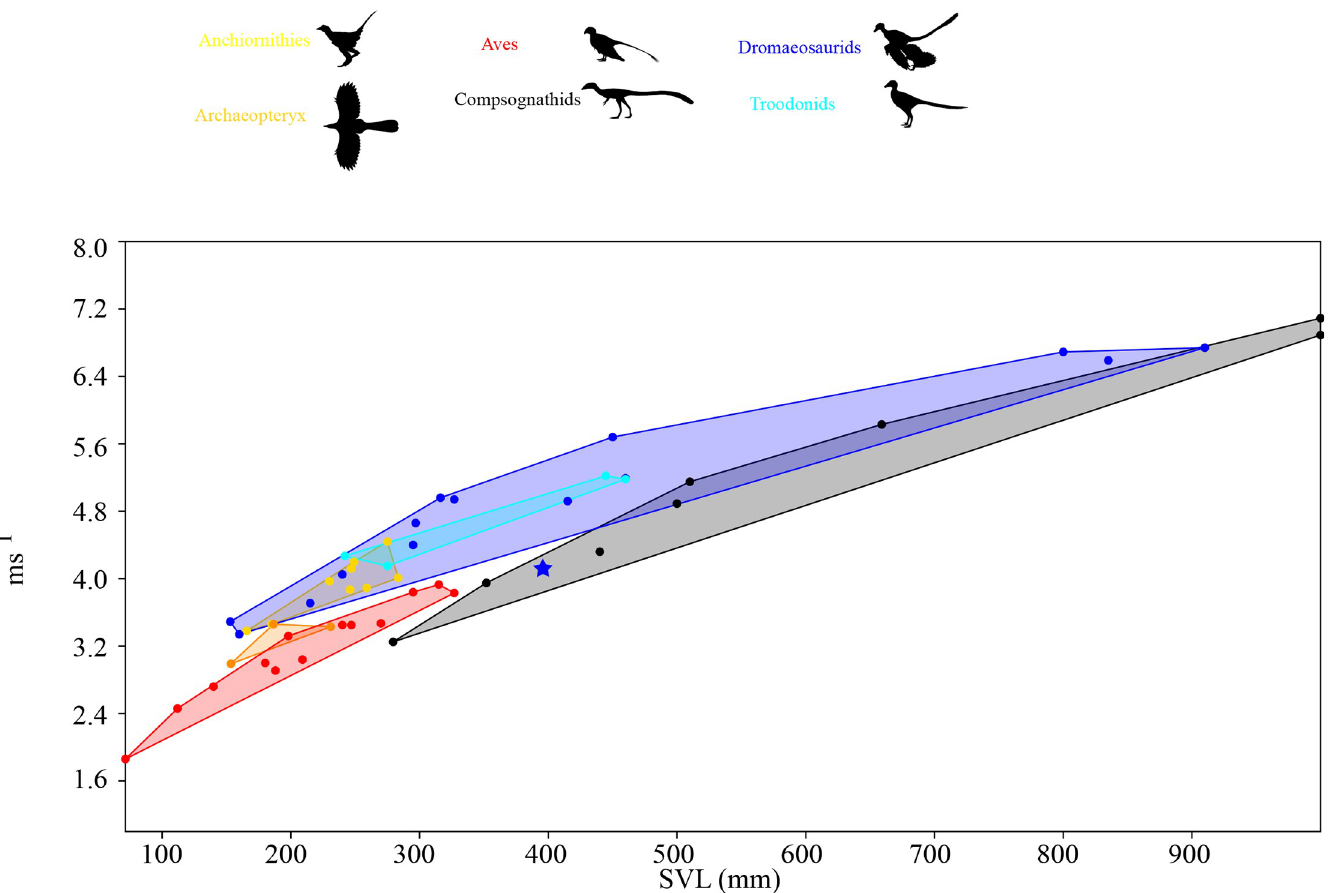
Fig 2. Comparisons of maximum speed potential between small coelurosaur clades. Top speed comparison between clades using speed calculated from equations in [28], though all reconstruction methods show similar patterns. The blue start represents Halszkaraptor , whose position is likely based on its proposed unique semi aquatic lifestyle. Of note, at lower speeds the dromaeosaurs, more specifically microraptorines, show distinctly higher top speed than comparably size compsognathids, Archaeopteryx specimens or basal birds and similar values to troodontids. Silhouette modified from those in Phylopic image repository (Phylopic.org) created by Joh Conway, Matt Martynuik, Gareth Monger and Brad McFeeters.